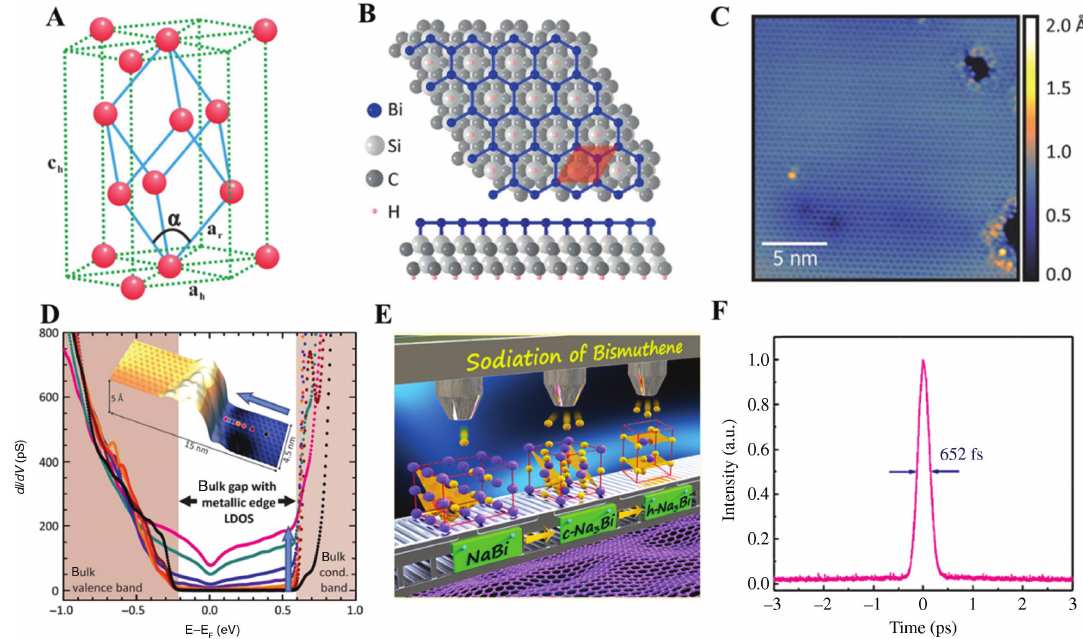
Figure 3: Structure, growth, physics and application of 2D Bi. (A) Rhombohedra structure (blue solid line) and hexagonal structure (green dashed line) of Bi. Reproduced with permission from Ref. [104]. Copyright 2017, American Chemical Society. (B) Schematic diagram of a bismuthene layer placed on the threefold-symmetric silicon carbide (SiC) (0001) substrate [105]. (C) The honeycomb pattern of the bismuthene. (D) Differential conductivity dI / dV (reflecting the LDOS) at different distances to the edge. (B–D) Reproduced with permission from Ref. [105]. Copyright 2017, The American Association for the Advancement of Science. (E) Schematic diagram of multistep phase transitions from Bi → NaBi → c-Na during Na + intercalation and alloying processes. Reproduced with permission from Ref. [106]. Copyright 2019, American Chemical Society. (F) Autocorrelation trace of mode-locking with few-layer bismuthine. Reproduced with permission from Ref. [107]. Copyright 2017, American Chemical